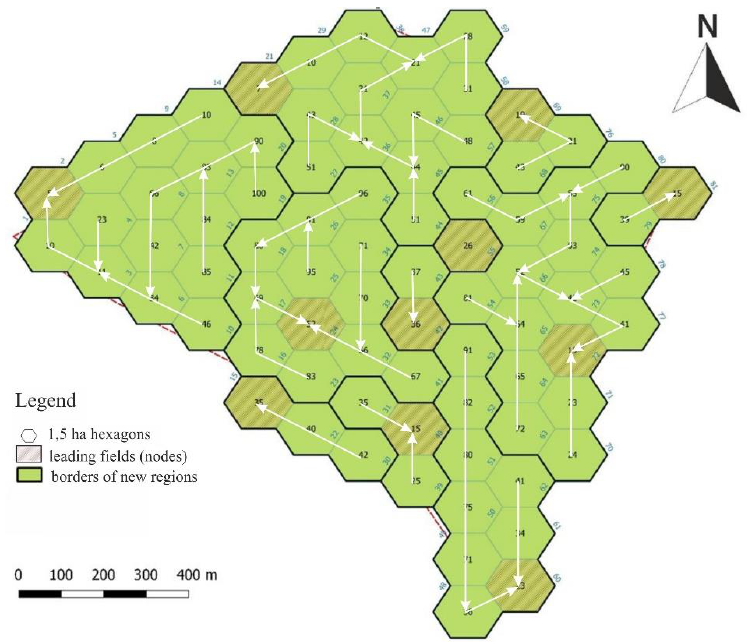
Figure 11. The first stage of aggregation of the landscape aesthetic value according to the minimum value decrease path. Key: white arrows show how the landscape aesthetic value decreases minimally.